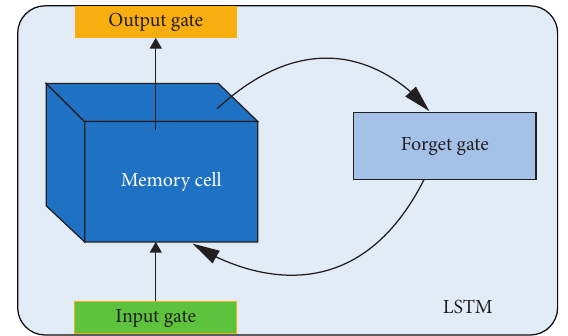
Figure 1: LSTM unit internal